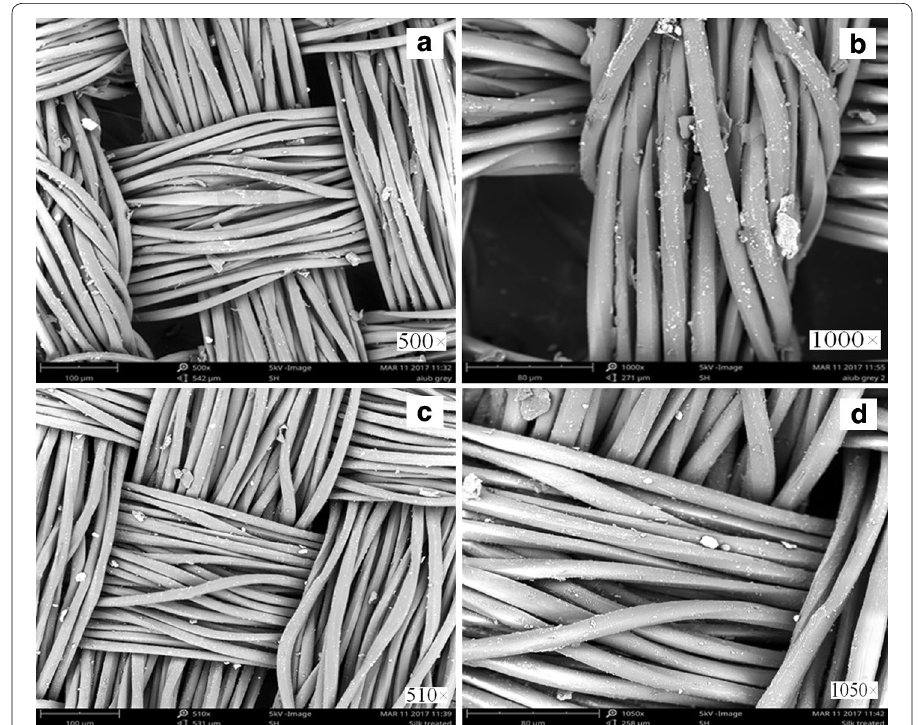
Fig. 4 SEM images of undyed ( a , b ) and dyed ( c , d ) polyester fiber samples at different